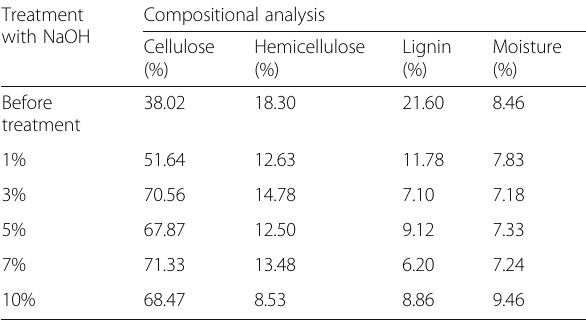
Table 1 Proximate composition of rice straw treated with NaOH and untreated straw